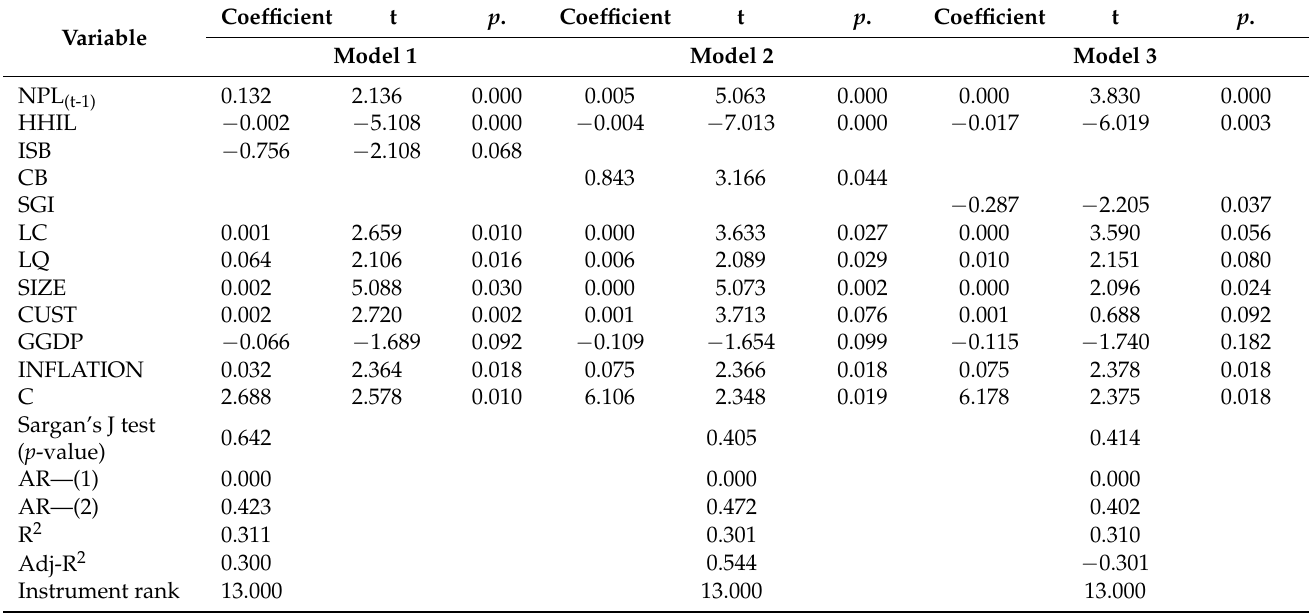
Table 7. Effects of competition (based on HHIL), loan quality and ownership structure on credit risk.